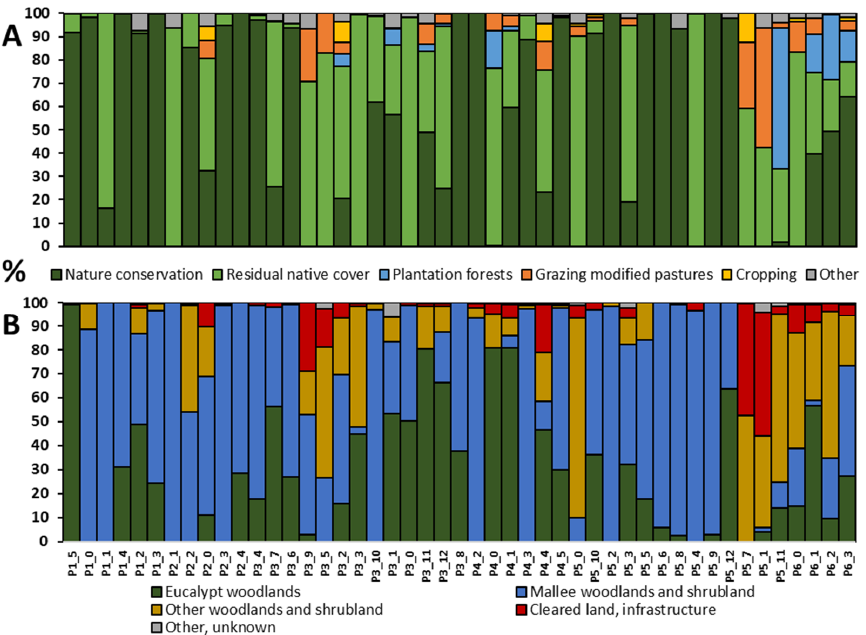
Figure 8. Land use and vegetation group composition of burned pixels (dNBR ≥ 100) for each fire. ( a ) Land use classes derived from the Australian Land Use and Management Classification V8 [43]. ( b ) Vegetation groups based on NVIS Major Vegetation Groups [42]. Visual inspection against ArcGIS Basemap imagery was used to confirm accurate land use and vegetation group classification. Fires listed chronologically as in Table 2.